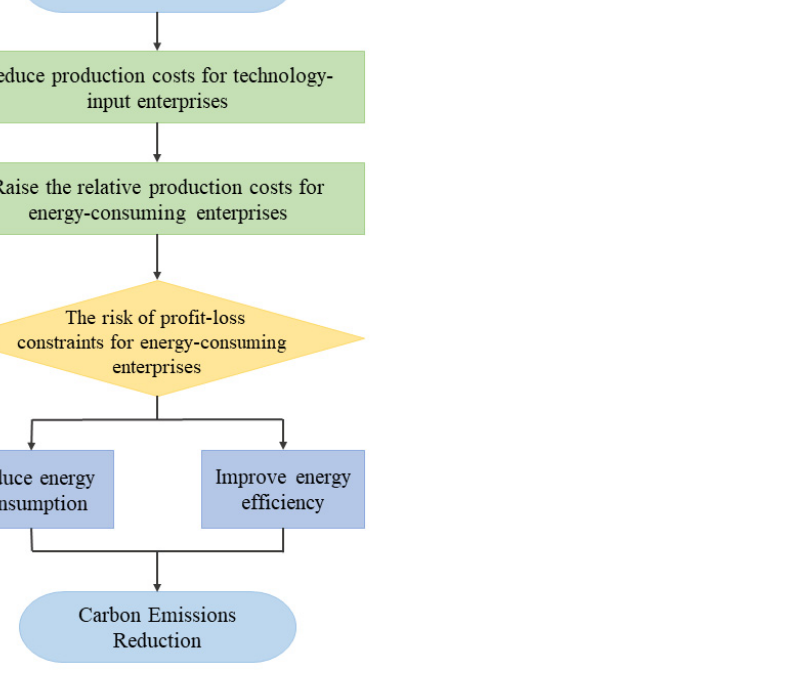
Figure 2. The internal mechanism of intelligent manufacturing to achieve carbon emission reduc- tion.